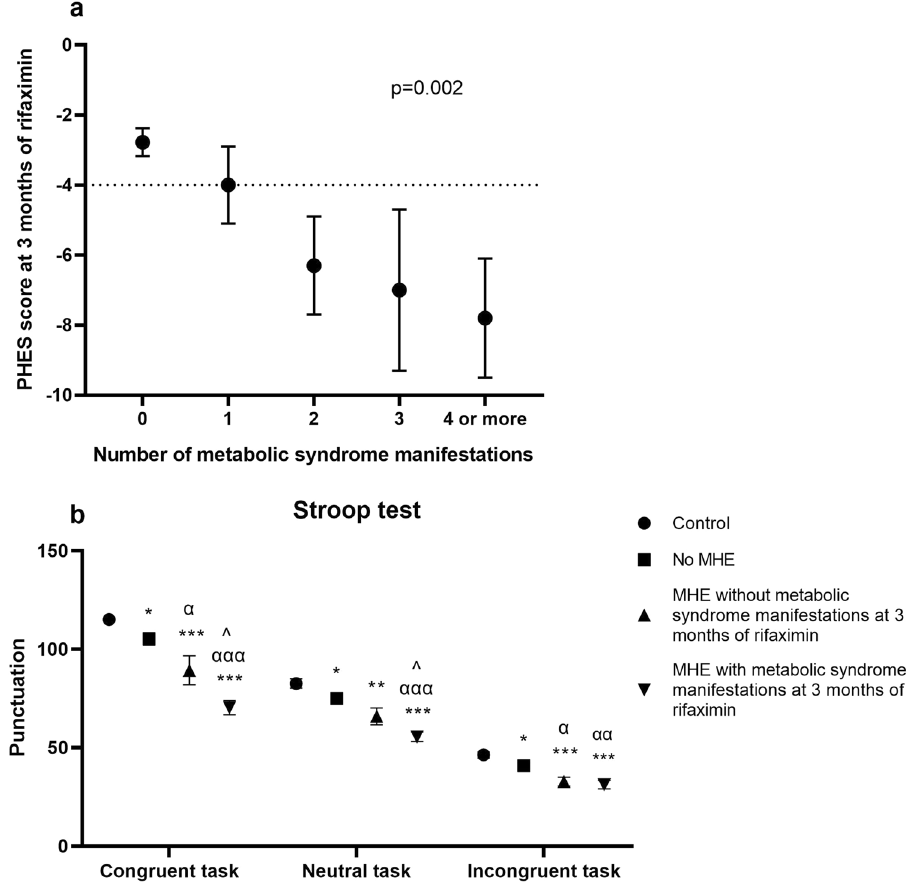
Figure 2. ( a ) Correlation between PHES and categorized number of metabolic manifestations at 3 months of rifaximin treatment. ( b ) Performance of Stroop test by controls, patients without MHE and patients with MHE according to presence of manifestations of metabolic syndrome at 3 months of rifaximin treatment. Stroop test: Congruent task: number of words read in 45 s; Neutral task: number of colours read in 45 s; Incongruent task: number of items completed in 45 s. Punctuation expressed as mean (SEM). *significant differences from controls (* p < 0.05; ** p < 0.01; *** p < 0.001). α significant differences from no MHE ( α p < 0.05; αα p < 0.01; ααα p < 0.001). ^significant differences from patients with MHE without metabolic syndrome manifestations (^ p < 0.05; ^^ p < 0.01; ^^^ p <